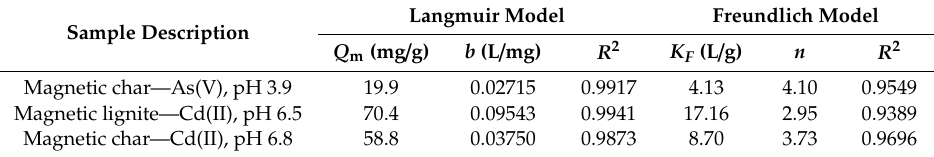
Table 4. Langmuir and Freundlich model parameters for magnetic char and magnetic lignite.